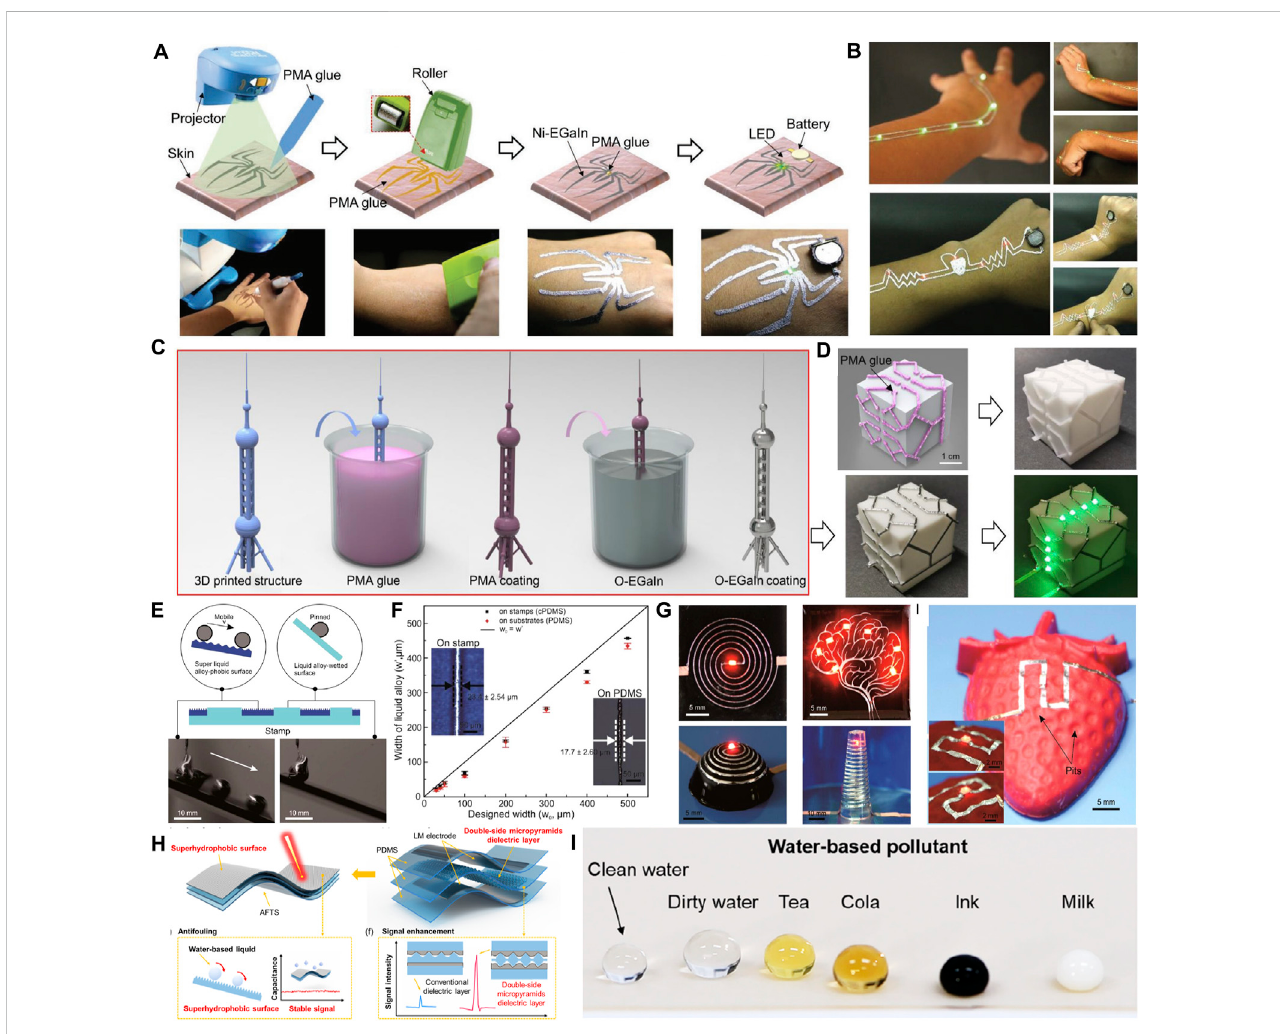
Printing methods based on selective adhesion substrates. (A) The schematic diagrams and the photographs of the Ni-EGaIn electronic tattoo printing process (Guo etal., 2019a). Copyright@2019, Wiley (B) Two examples ofNi-EGaInelectronic tattoo with LEDarray (Guo etal., 2019a). Copyright@2019, Wiley (C) Brief illustration of the whole process of 3D transfer printing (Guo et al., 2021). Copyright@2021, Elsevier (D) The O-EGaIn electronics on the surface of a cube and square pyramid (Guo et al., 2021). Copyright@2021, Elsevier (E) A selectively amphiphilic patterned plate for fl exography printing of liquid alloy (Zhang et al., 2019). Copyright@2021, ACS (F) Designed and measured widths of liquid alloy lines on stamps/plates (UVtreated cPDMS) and receiving/target substrates (PDMS) (Zhang et al., 2019). Copyright@2019, ACS (G) These are a helix circuit of ~200 μ m width on various 3D surfaces (Zhang et al.,